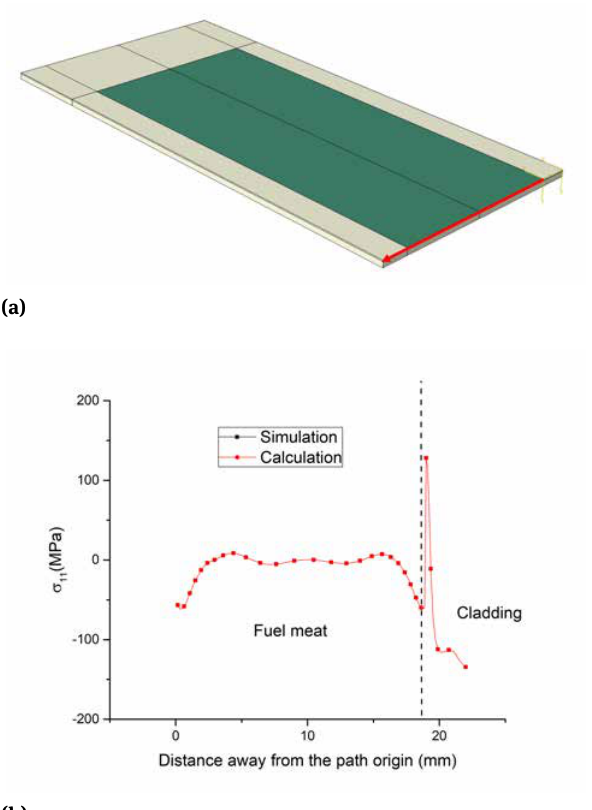
Figure 5: Verification of elastic constitutive relation